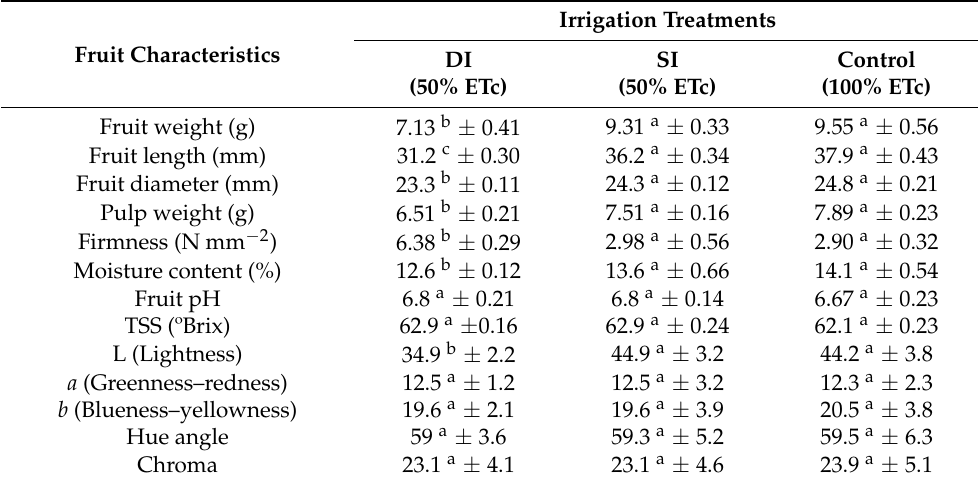
Table 5. The average values of two years of data ± standard deviation of physiochemical properties of date palm (Khalas cv.) recorded at the Tamar stage in drip irrigation (DI) and subsurface irrigation (SI) systems at 50% ETc compared with the bubbler irrigation system (control) at 100% ETc. Irrigation Treatments Fruit Characteristics DI SI Control (50% ETc) (50% ETc) (100% ETc) Fruit weight